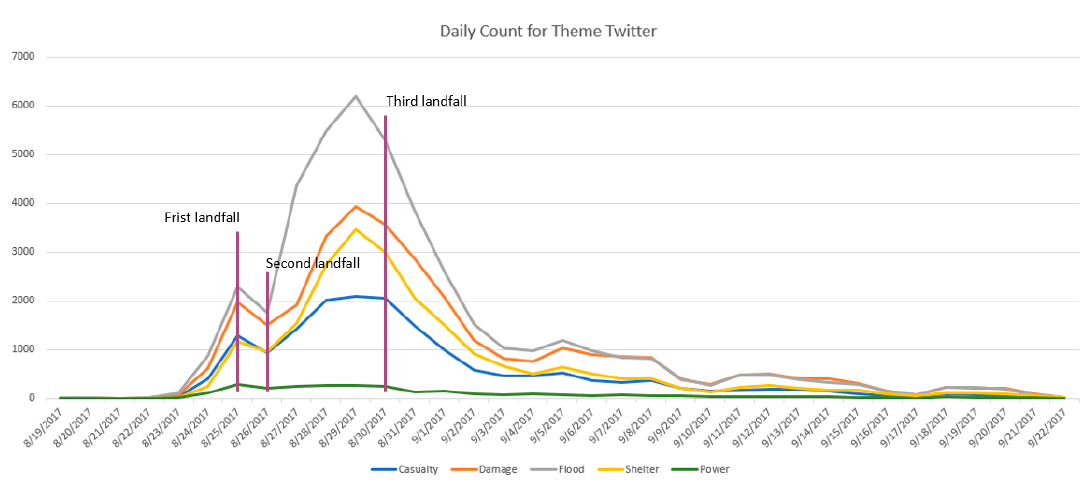
Figure 5. Temporal distribution for 5 theme-related daily twitter count.